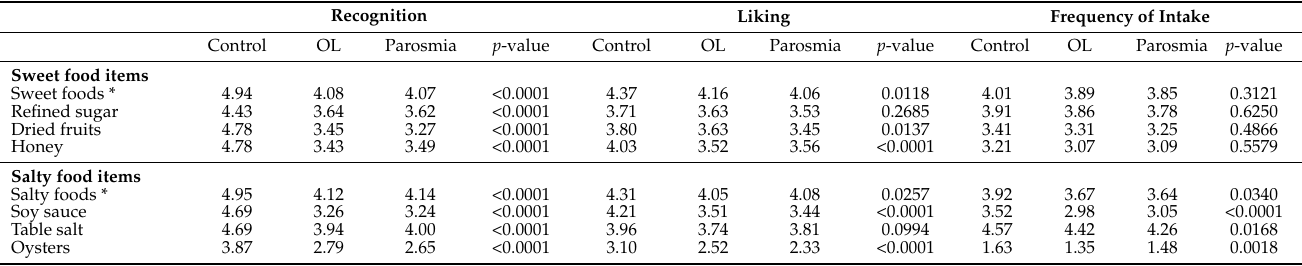
Table 3. Recognition, liking, and frequency of intake for food items and taste categories in normosmic controls, patients with olfactory loss (OL), and patients with parosmia. Recognition was rated by how likely the participant was to recognise the food item during consumption using taste, smell, and mouthfeel combined. Liking was rated for the current liking of food items ranging from disgust to pleasure. Ratings of recognition, liking, and frequency of intake ranged from 1–5, where 1 indicated lowest possible and 5 indicated highest possible. Control: Normosmic controls; OL: Olfactory loss group. * indicates general scores of the basic tastant (asked without mentioning specific food